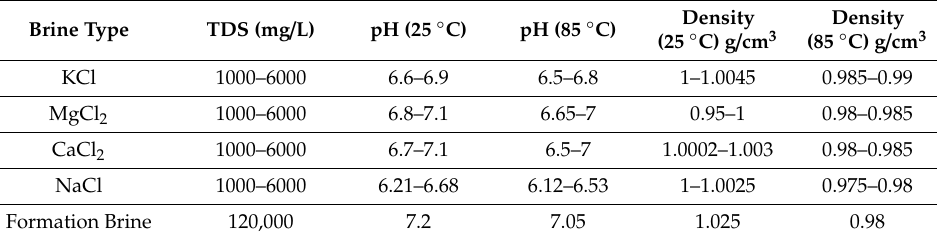
Table 1. Brine properties for each